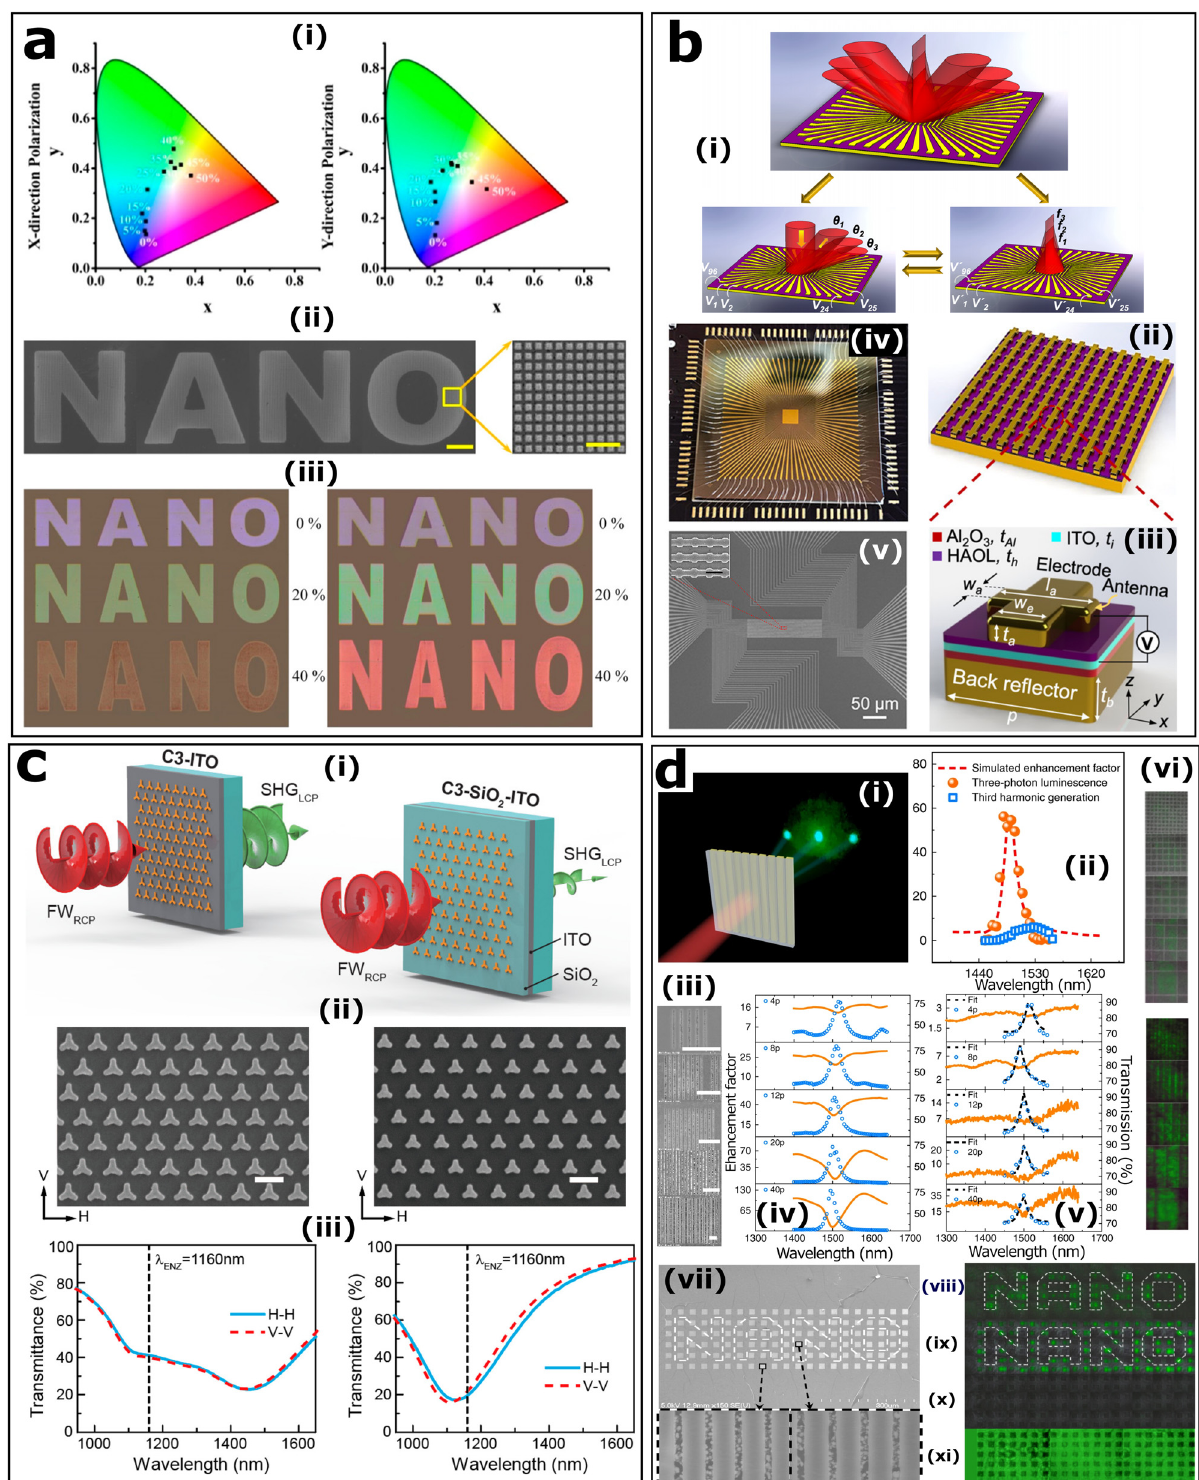
Figure 7: Reconfigurable metasurfaces and nonlinear metasurfaces. (a): (i) Tunable structural colors of x -polarized light and y -polarized light with varying strains in the CIE 1931 color map. (ii) SEM image of the “ NANO ” patternandthepartialmagni fi cationofthemicrostructure.Scalebar:50µm(left),1µm(right).(iii)Opticalimagesat x -polarized(left) and y -polarized(right)lightwithdifferentstrains.Reproducedwithpermissionfromref.[147].Copyright2019,AmericanChemicalSociety.(b): (i) Schematic of the metasurface with switchable functions, i.e., dynamic beam steering and cylindrical metalens with recon fi gurable focal length. Schematic of periodic array (ii) and unit cell (iii) of the antenna elements. (iv) Photograph of the metasurface with 96 independently addressable elements. (v) SEM images of the addressable metasurface. Scale bar: 50 µm, and 500 nm for the insets. Reproduced